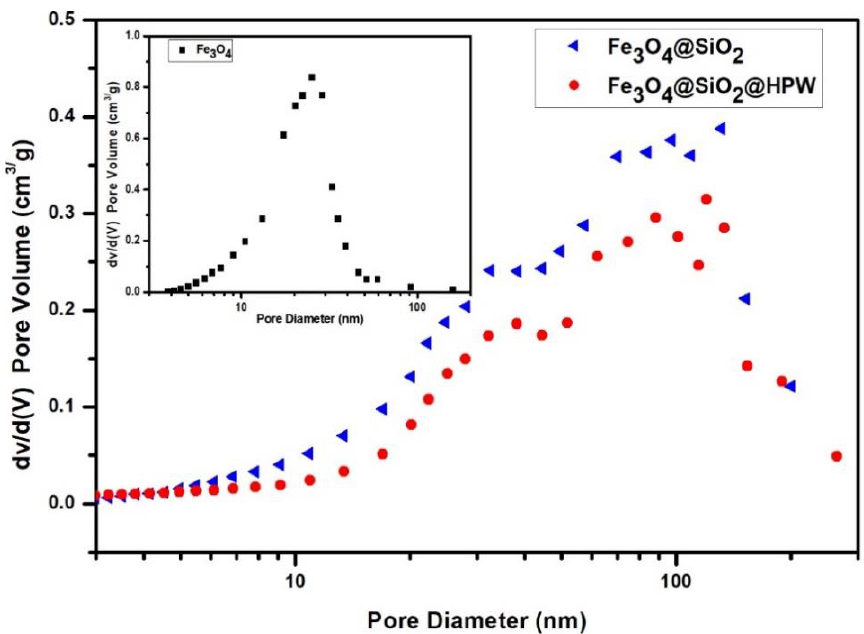
Figure 9. The pore size distribution of Fe 3 O 4 , Fe 3 O 4 @ SiO 2 , and Fe 3 O 4 @ SiO 2 @HPW .